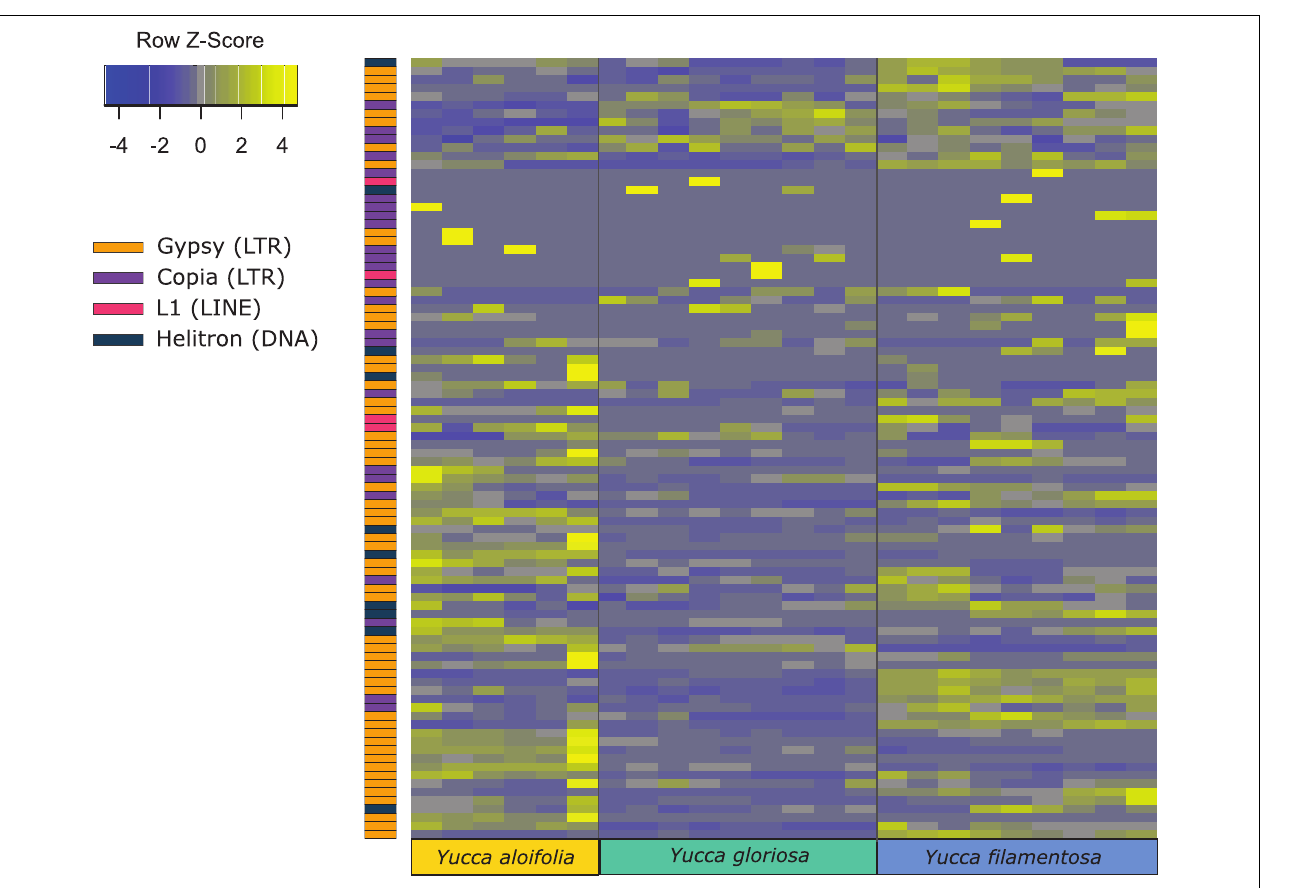
FIGURE 5 | Heatmap of normalized and scaled expression of 92 repeat families that were both present in all three species and had any detectable expression in any library. Individual rows are repeat clusters, and columns represent individual RNA-seq library replicates for each